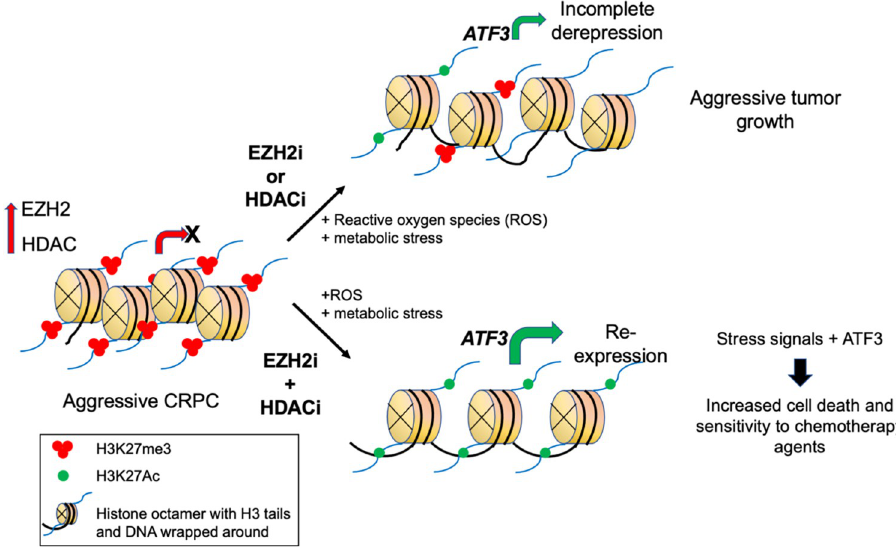
Fig 1. Targeting EZH2 and HDACs results in cytotoxic effects in castration-resistant prostate cancers by derepressing stress response pathways. CRPC is associated with tight suppression of large numbers of pro- tumorigenic genes due to increased expression of EZH2 and HDACs. Individual targeting of EZH2 or HDACs using small molecule inhibitors (EZH2i or HDACi) leads to incomplete derepression of tightly suppressed genes. EZH2i alone leads to only partial removal of the inactivating H3K27me3 mark by suppressing EZH2 activity; similarly, HDACi results in only partial accumulation of the activating H3K27ac mark at target genes. Combined treatment with EZH2i or HDACi resulted in the active chromatin (H3K27ac) configuration at promoter regions and deep derepression of several genes silenced in CRPCs. One such target gene relevant to resistance of CRPC is ATF3 that is a stress response gene. ATF3 is significantly up-regulated due to ATF3 promoter activation by combination drug treatment as well as induction of ROS and metabolic stress by these inhibitors. While EZH2i and HDACi individually also cause ROS induction and metabolic stress, it is not sufficient to activate ATF3 due to retention of inactive chromatin at the ATF3 promoter. Up-regulation of ATF3 in the presence of ROS and metabolic signals results in killing of CRPCs. ATF3, activating transcription factor 3; CRPC, castration-resistant prostate cancer; EZH2, enhancer of zeste homolog 2; HDAC, histone deacetylase; ROS, reactive oxygen species.